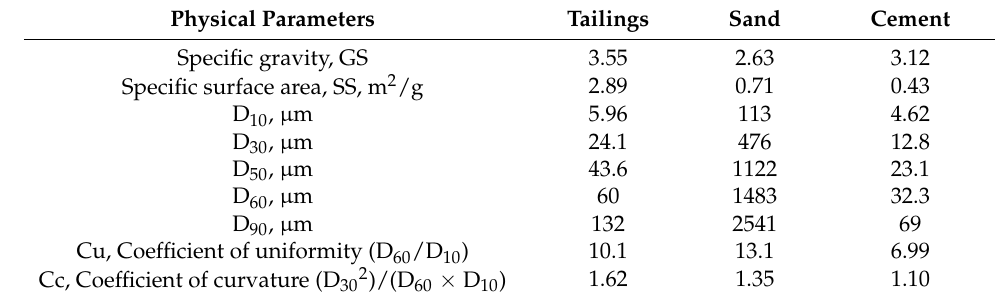
Figure 1. Cumulative PSD curves of Cu-rich tailings and sand. Table 1. A summary of basic physical features of tailings, sand, and cement. Physical